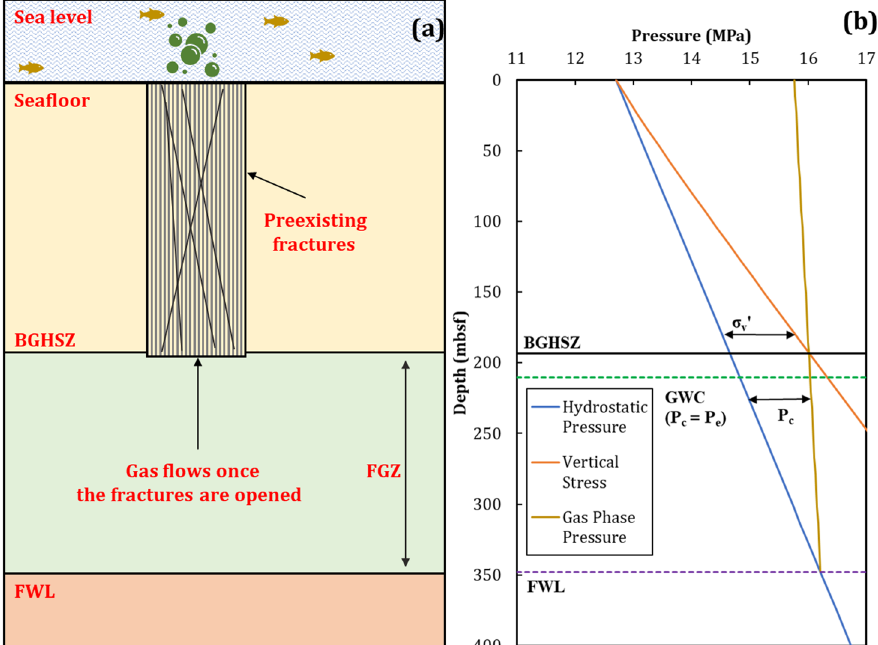
Figure 3. Illustrative example ( a ) of pressure and stress ( b ) at the VR. The BGHSZ forms a low- permeability seal, and the gas phase is trapped forming the FGZ. The purple line is the free water level (FWL) depth if we only account for the buoyancy effect. The green line is the GWC depth if we account for both the buoyancy and capillary pressure ( P c ) where the capillary pressure at GWC is equal to the capillary entry pressure ( P e ). Fractures are opened at the BGHSZ once the gas pressure (yellow line) overcomes the vertical stress (orange line) as the fracture criterion (Equation (11)).